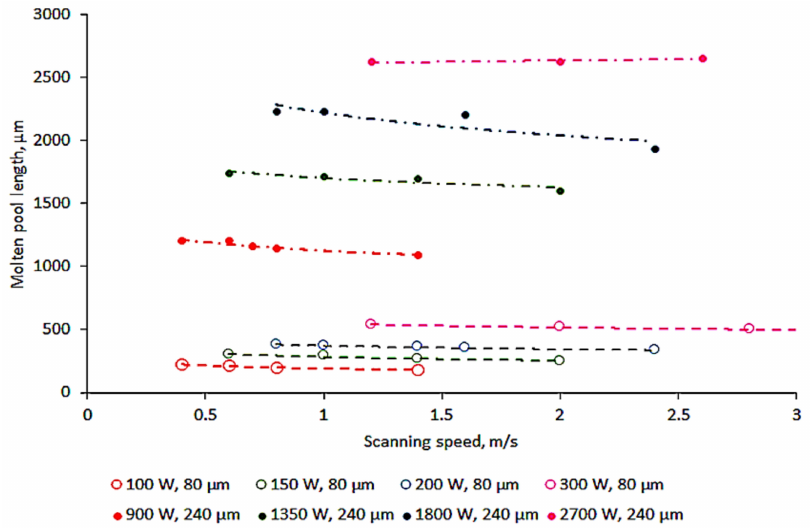
Figure 10. Calculated length of the molten pool versus scanning speed, laser power and spot